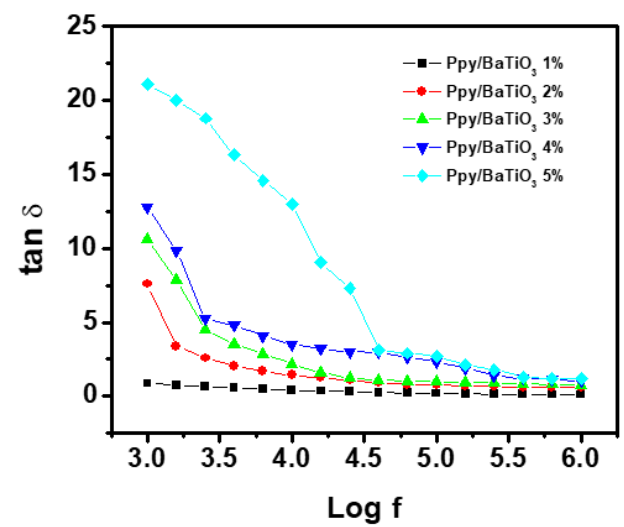
Polymers 2018 , 10 , x FOR PEER REVIEW Figure 11. Variation of dissipation factor as a function of AC frequency for PPy/BaTiO 3 composites.